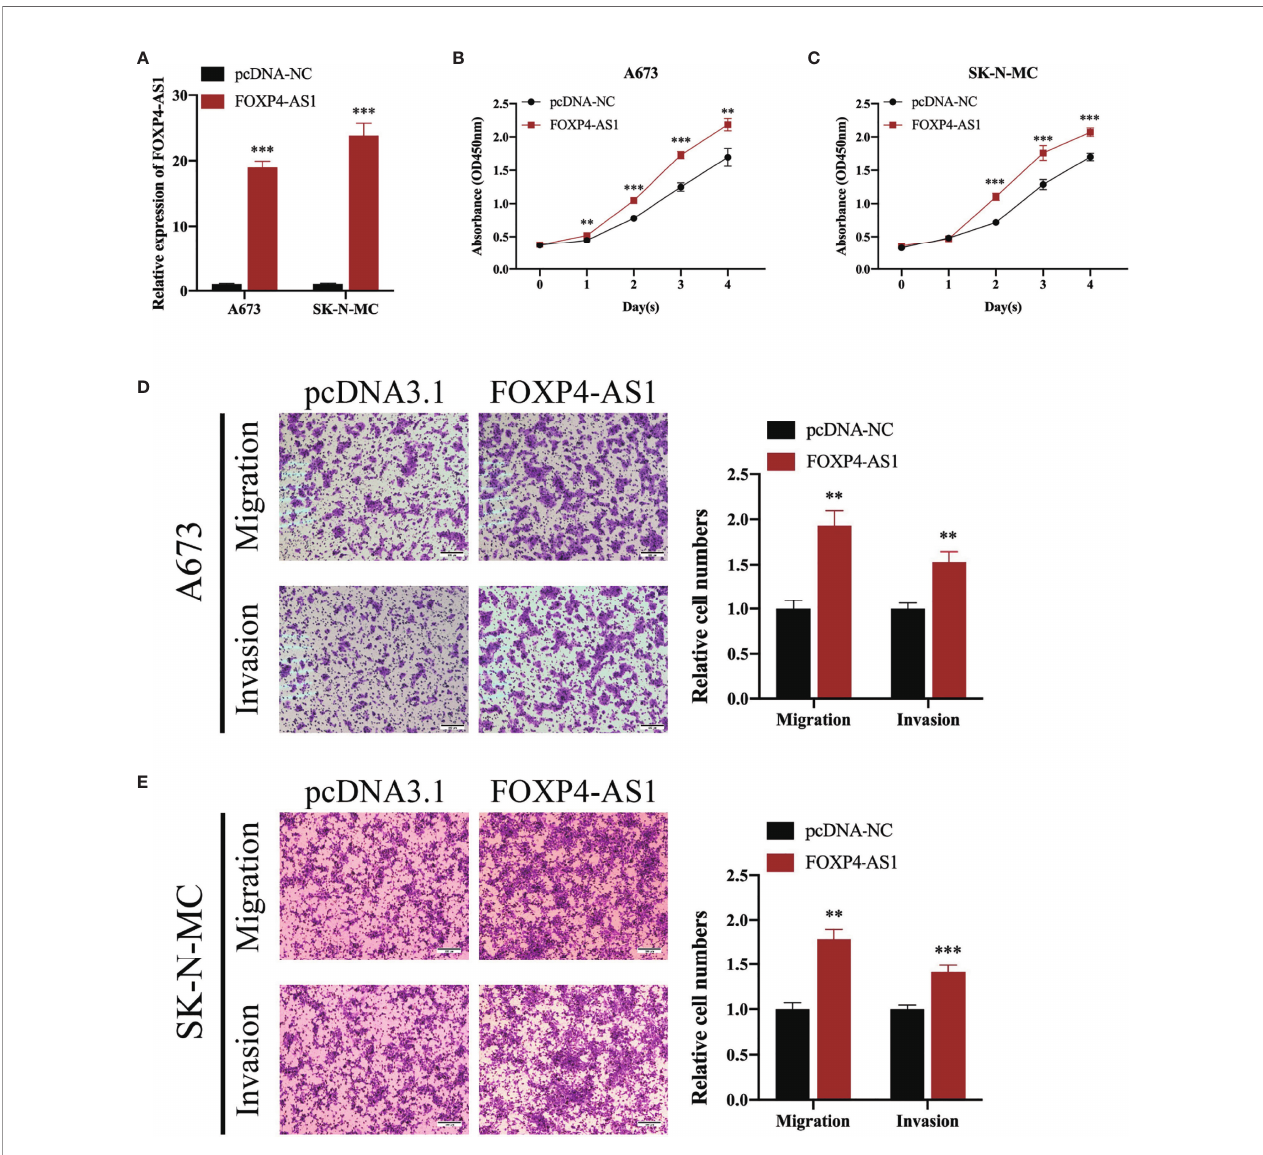
FIGURE 3 | Overexpressing FOXP4-AS1 enhances cell proliferation, migration, and in fi ltration of ES. (A) Transfecting overexpression plasmid upregulated FOXP4- AS1 in ES cell lines A673 and SK-N-MC. (B, C) CCK-8 assay showed that FOXP4-AS1 overexpression enhanced growth of ES cells. (D, E) Transwell migration along with in fi ltration assays revealed that up-regulating FOXP4-AS1 enhanced cell migration and in fi ltration of ES. **p < 0.01, ***p <